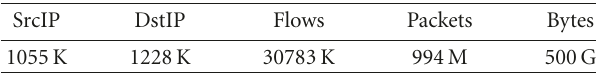
Table 8: Workload of Fred-eZone WiFi network over one day. SrcIP DstIP